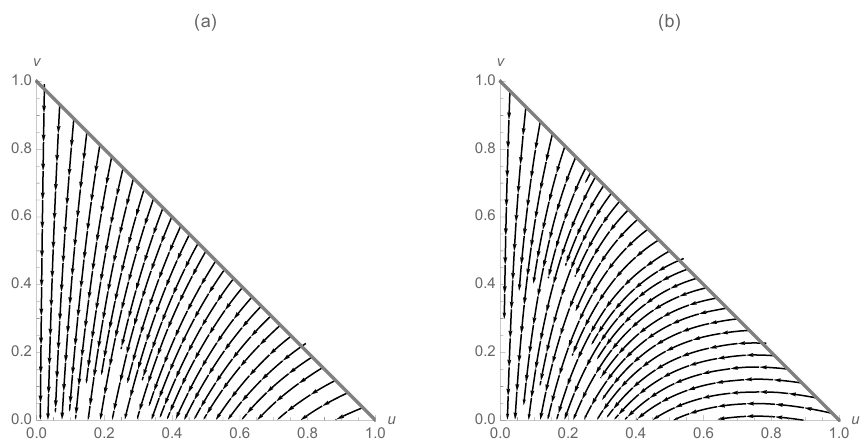
Figure 1. ( a ) Trajectories for R 0 < 1 and ( b ) trajectories for R 0 >